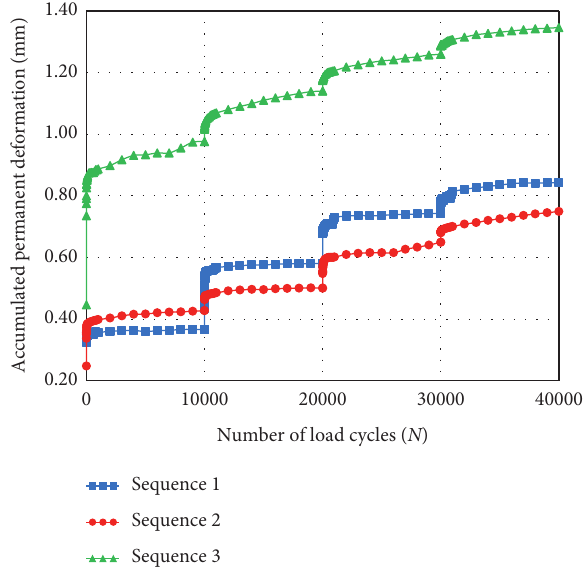
Figure 4: Accumulated permanent deformation measured from the RLT tests of the AB material.